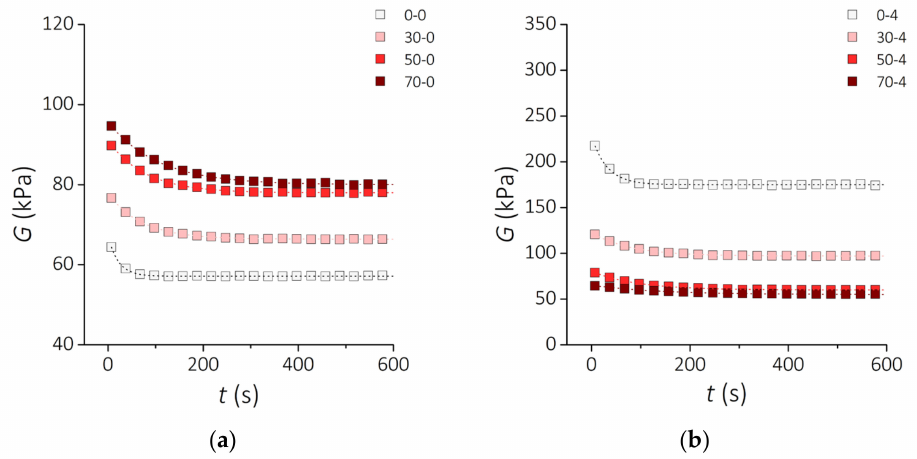
Figure 8. Rheological properties of the PDMS-MPs composites. Relaxation modulus G as a function of time for the samples ( a ) before incubation and ( b ) after 4 weeks incubation. Square symbols represent the measurement points. Dashed lines show the fit to the standard linear solid model.